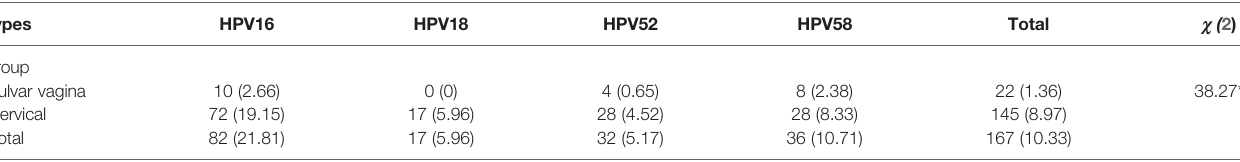
TABLE 4 | Distribution of high-grade lesions and cancer ( n